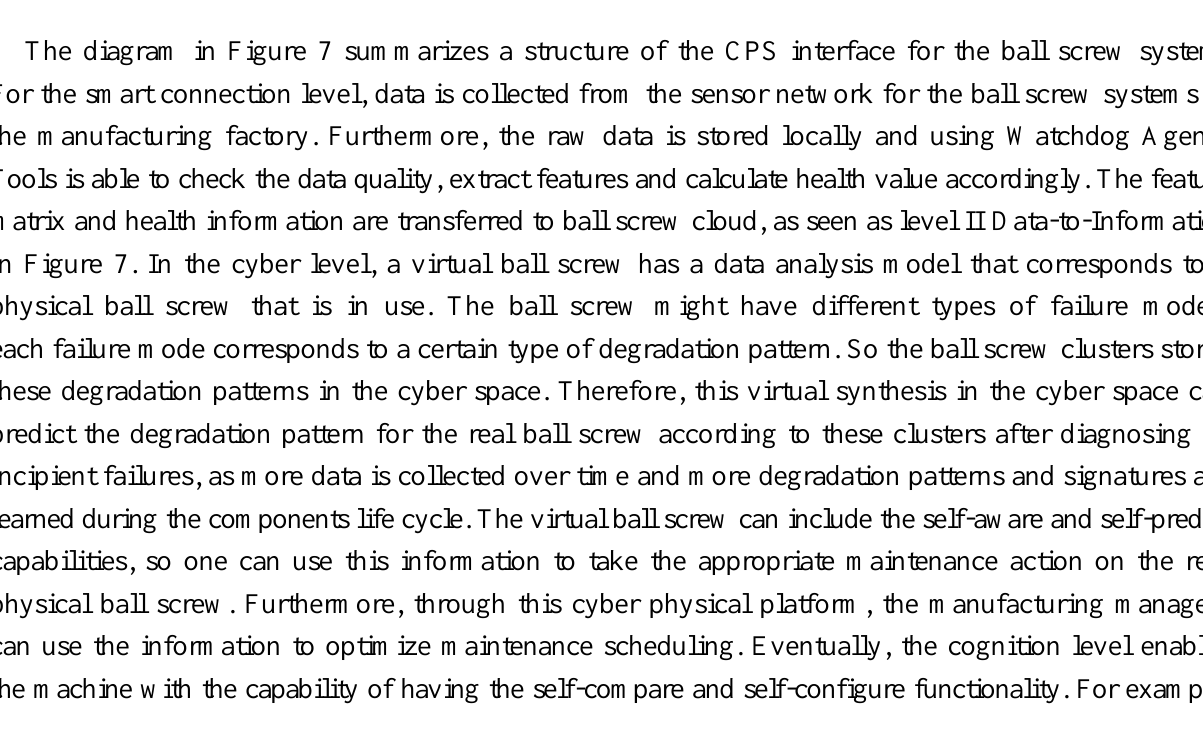
Figure 6. Position Error